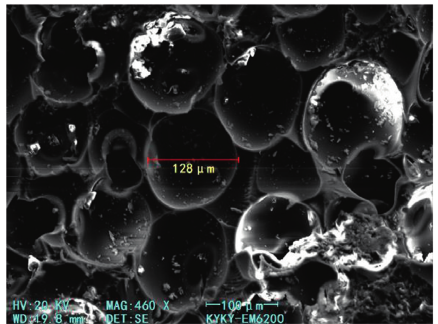
Figure 11: Microscopic characteristics of high density.